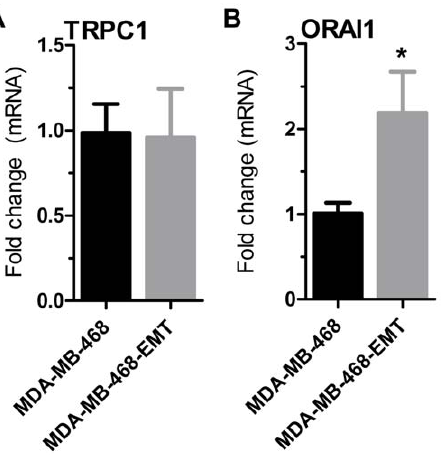
Figure 4. mRNA levels of TRPC1 and ORAI1 with EGF-induced EMT. TRPC1 ( A ) and ORAI1 ( B ) mRNA levels in MDA-MB-468 breast cancer cells stimulated with EGF to induce EMT. Values show mean 6 S.D. for nine wells from three independent experiments; * P , 0.05 (unpaired t-test).